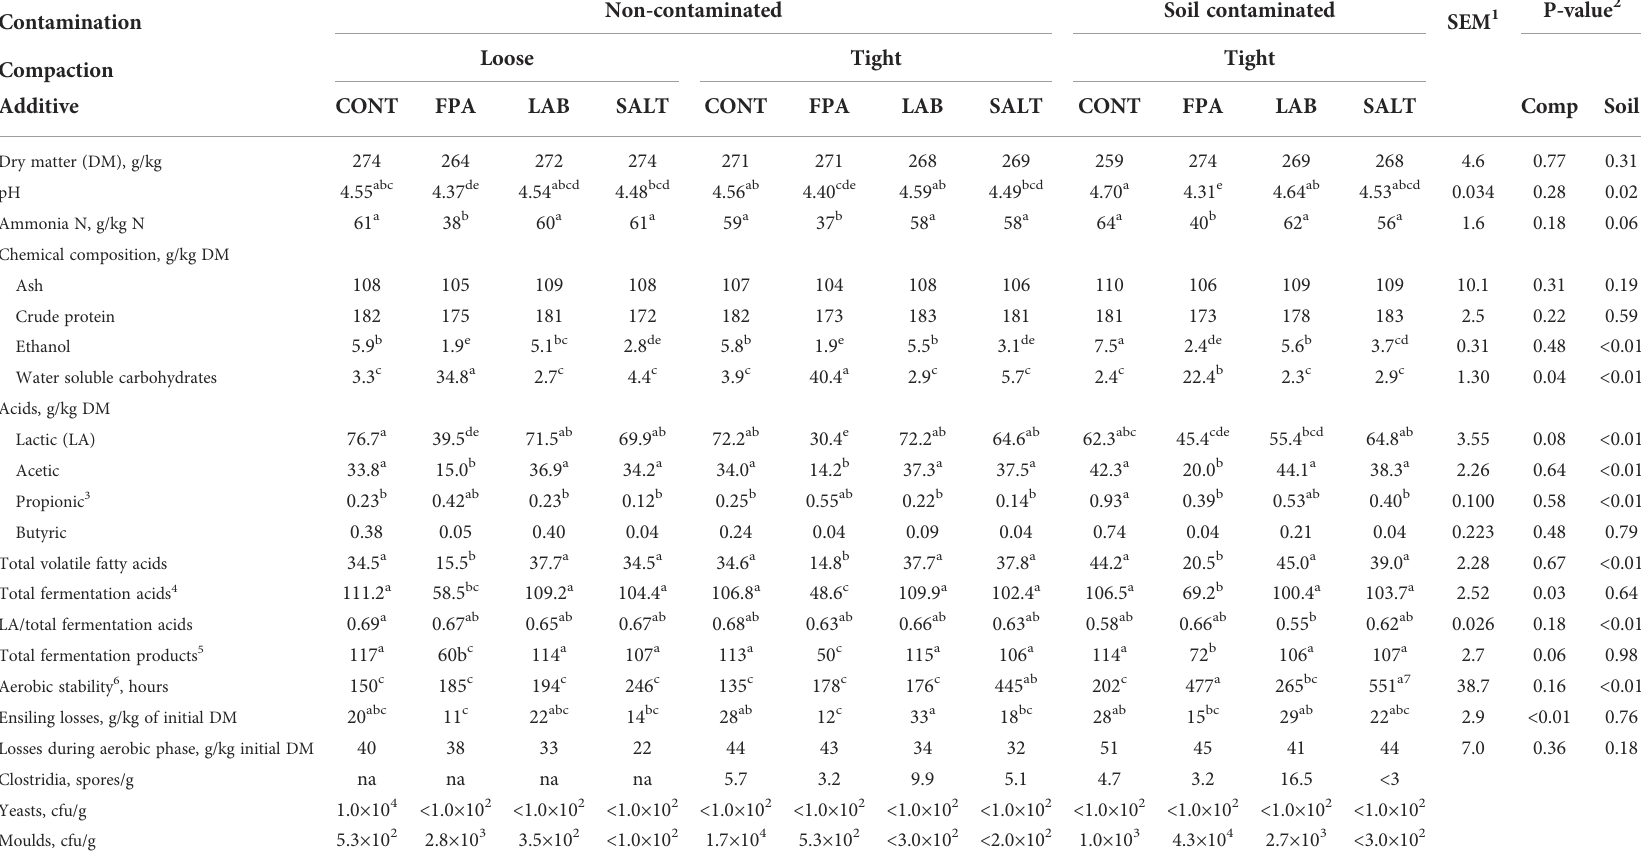
CONT:Control,FPA:Formicandpropionicacid-basedadditive,LAB:Lacticacidbacteriainoculant,SALT:Salt-basedadditive.Valueswithsameletterinaroware notsigni fi cantlydifferentat5%Tukeytest.IftherewerenodifferencesinTukeytest,letters were removed. 1 Standard error of the mean. 2 Effect of compactions and soil contamination. 3 Corrected for its amount in the FPA based additive. 4 Total volatile fatty acids + lactic acid. 5 Total fermentation acids + ethanol. 6 Time taken to increase the temperatureofsamplesby2°Cabovetheambienttemperature(22°C). 7